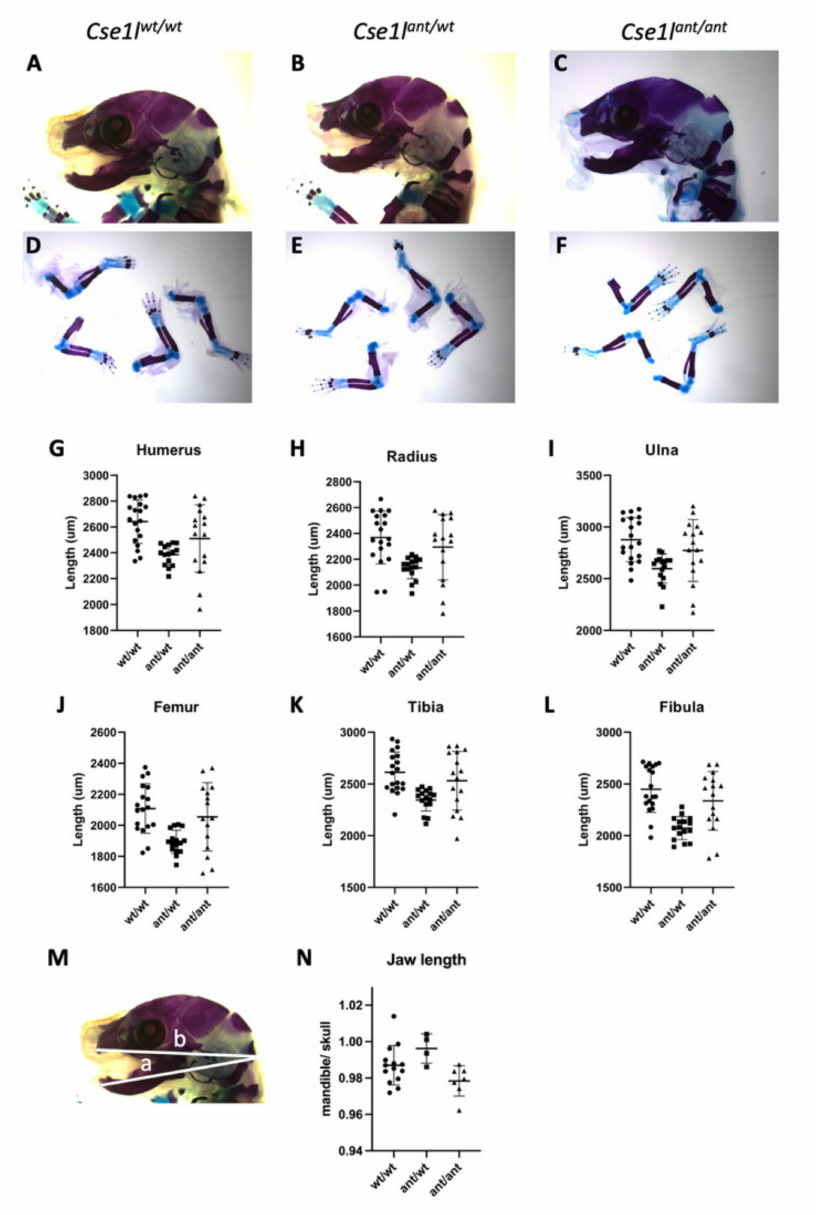
Figure 5. Cse1l mutant skeletal analysis. Wild-type Cse1l wt/wt ( A , D ), Cse1l ant/wt ( B , E ) and Cse1l ant/ant ( C , F ) skull and limb skeletal preparations. ( G – L ) Lengths shown for humerus ( G ), radius ( H ), ulna ( I ), femur ( J ), tibia ( K ), and fibula ( L ). Measurements as outlined in ( M ) are quantified and shown in ( N